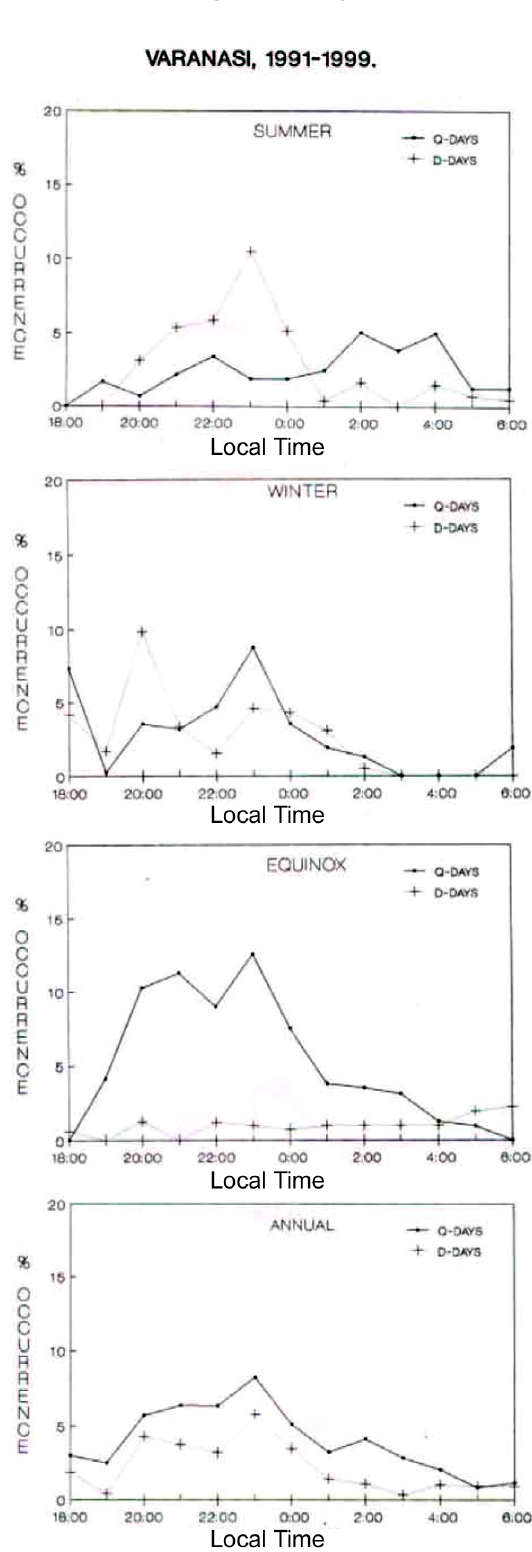
Fig. 6. Variation of the occurrence of scintillation over Varanasi on magnetically quiet and disturbed days in different seasons are given as summer, winter, equinox and